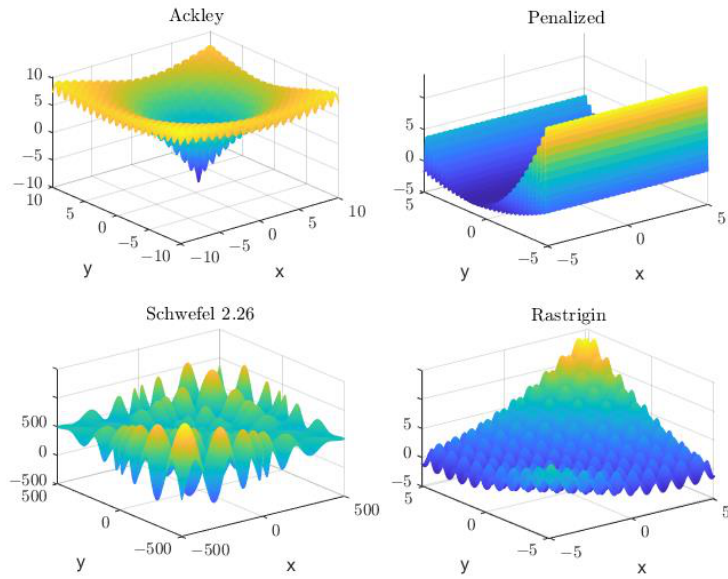
Figure 2. Schematic diagram of test function.